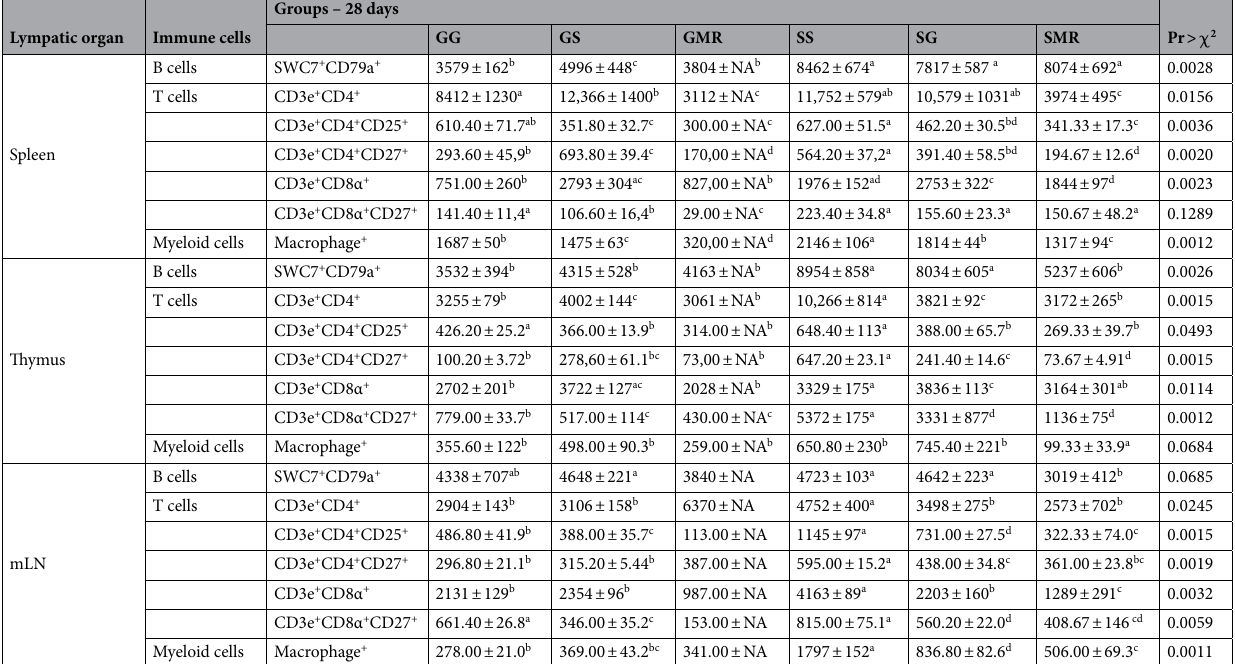
Table 2. Stimulation proliferation index for lymphocytes from lymphoid organs during the weaning period (28 days of age). The analysis was performed with the Kruskal–Wallis tests and data are shown as Mean ± SEM. a,b,c,d Different superscript letters indicate significant statistical difference ( P ≤ 0.05). The stimulation proliferation (S.I.) index was determined by CFSE dilution and the geometric mean values of the concanavalin A-stimulated duplicates were calculated and divided by the geometric mean values of the PBMC- nonstimulated control